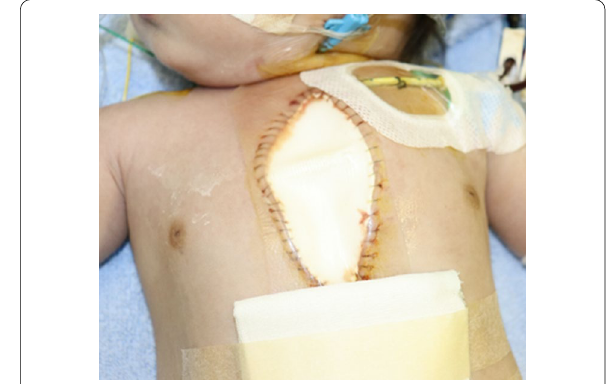
Fig. 1 A hydrocolloid wound dressing was applied to entirely cover the wound and the suture